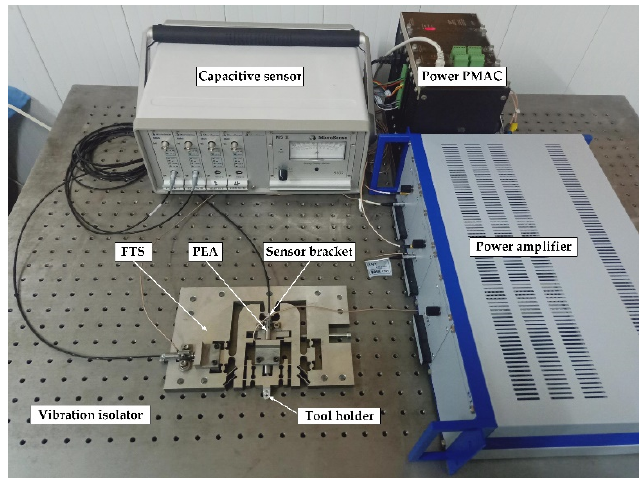
Figure 14. Experimental setup for performance testing.